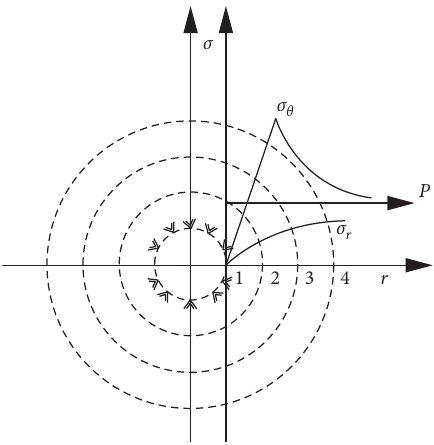
Figure 1: Stress diagram of elastic-plastic surrounding rock